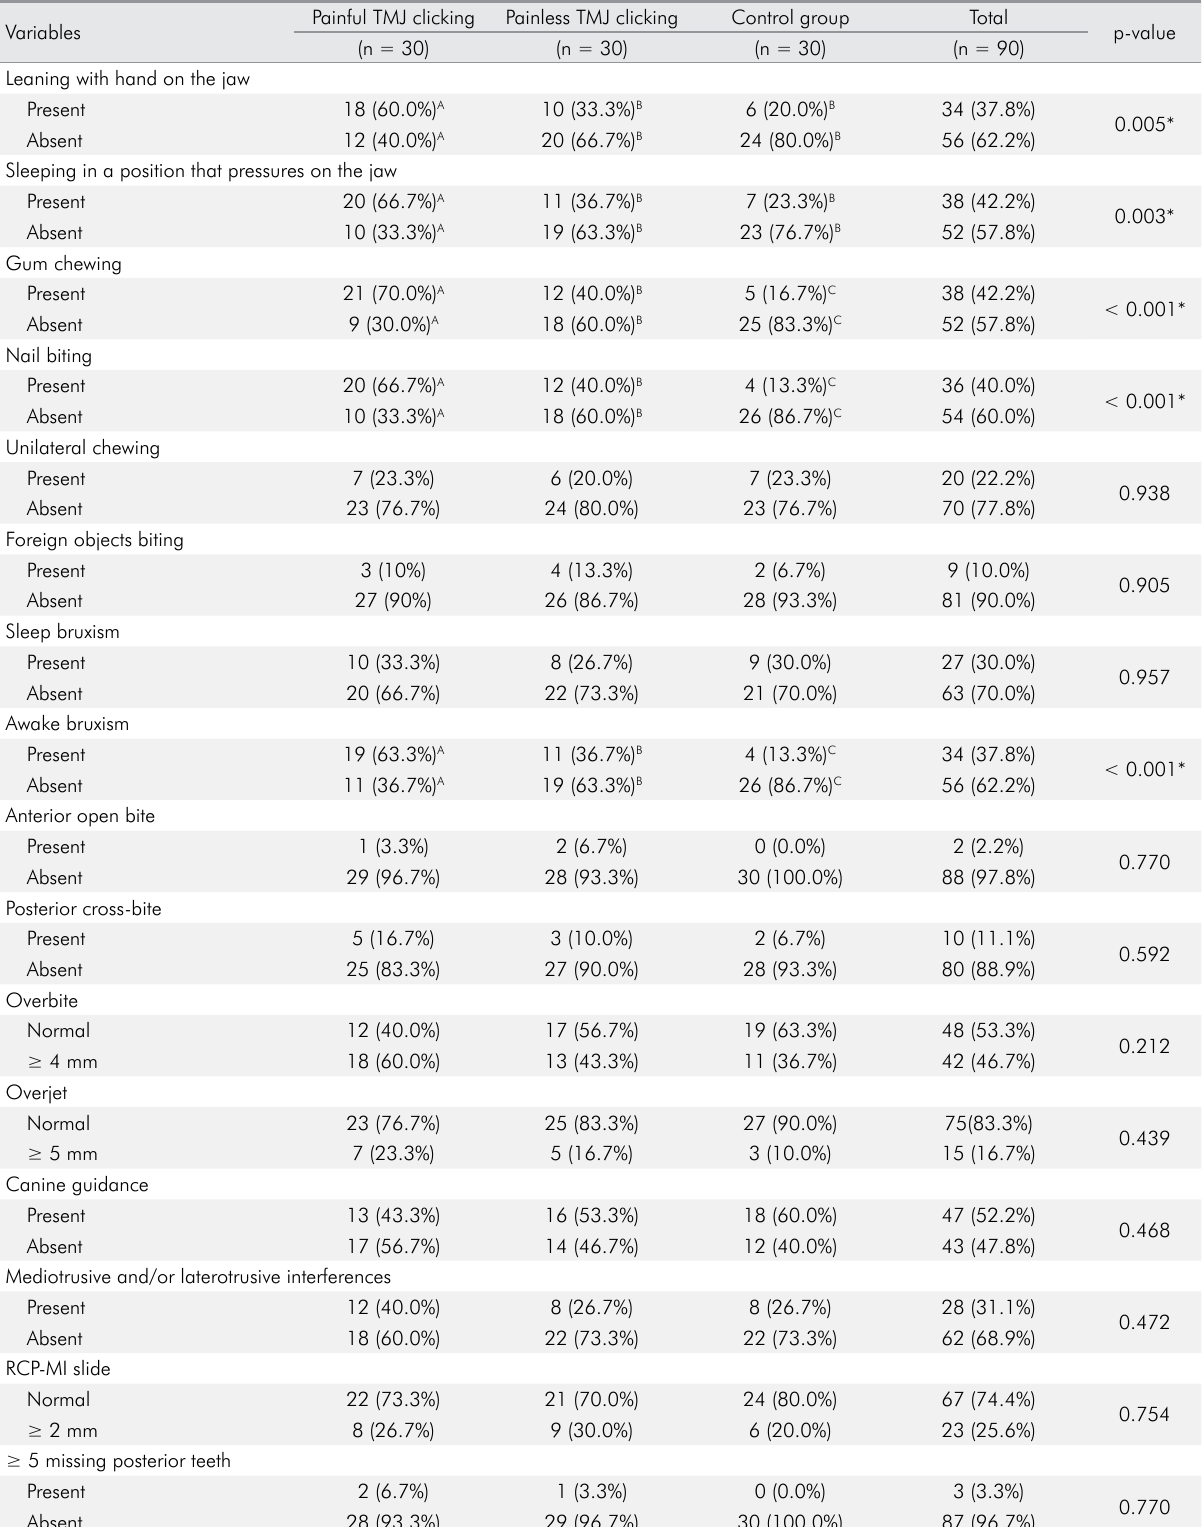
Table 1. Descriptive data for oral behaviors, bruxism, and malocclusion plus p-value of chi-square test (frequency).